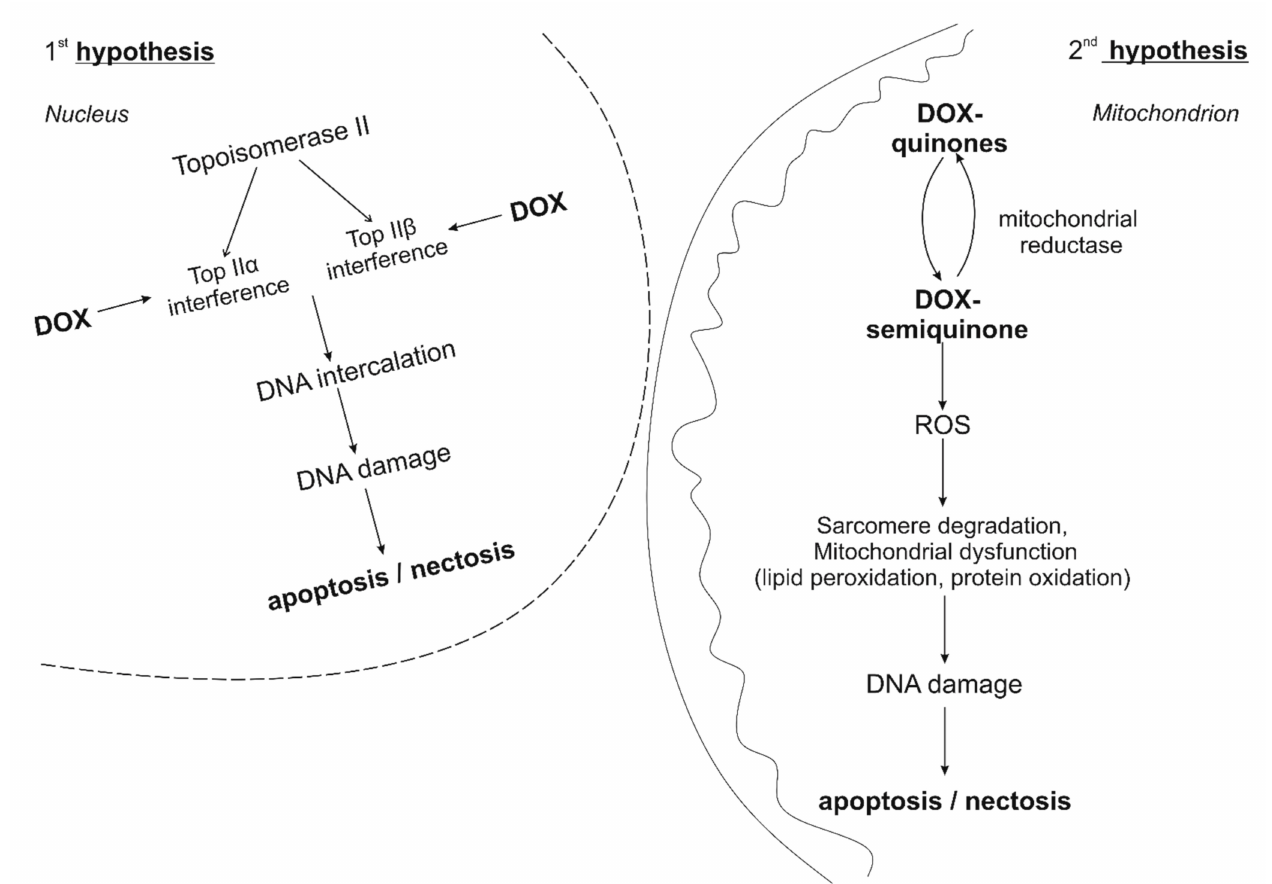
Figure 1. Features of the development of doxorubicin